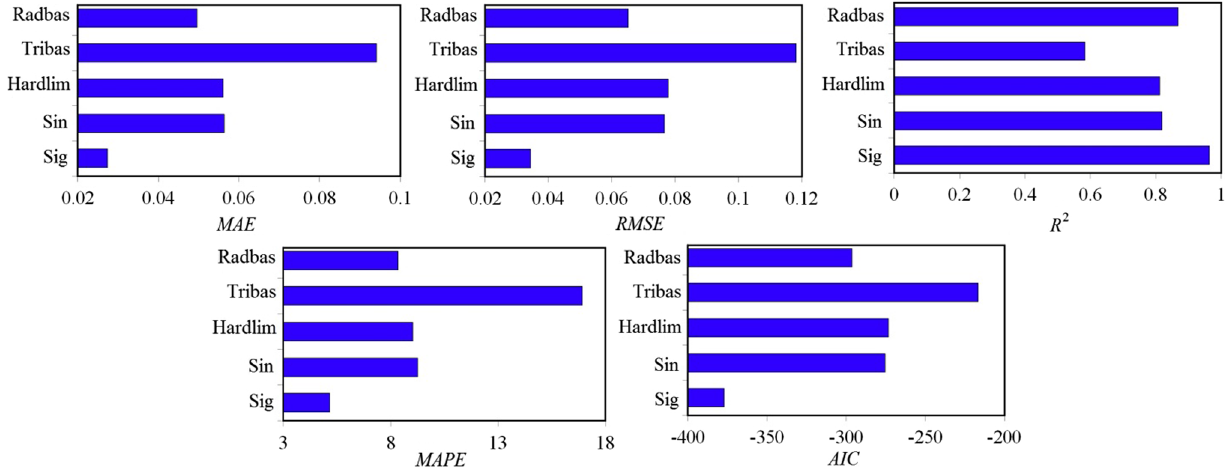
Fig. 5 Comparison of statistical indices for different activation functions of SAELM